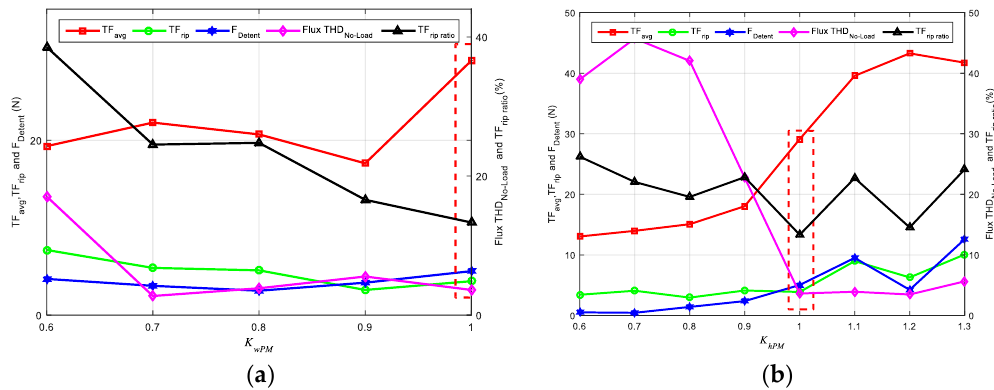
Figure 10. Influence of PM dimensions on DSLFSPMM-M3: ( a ) Comparison of different K wPM values; ( b ) Comparison of different K hPM values.